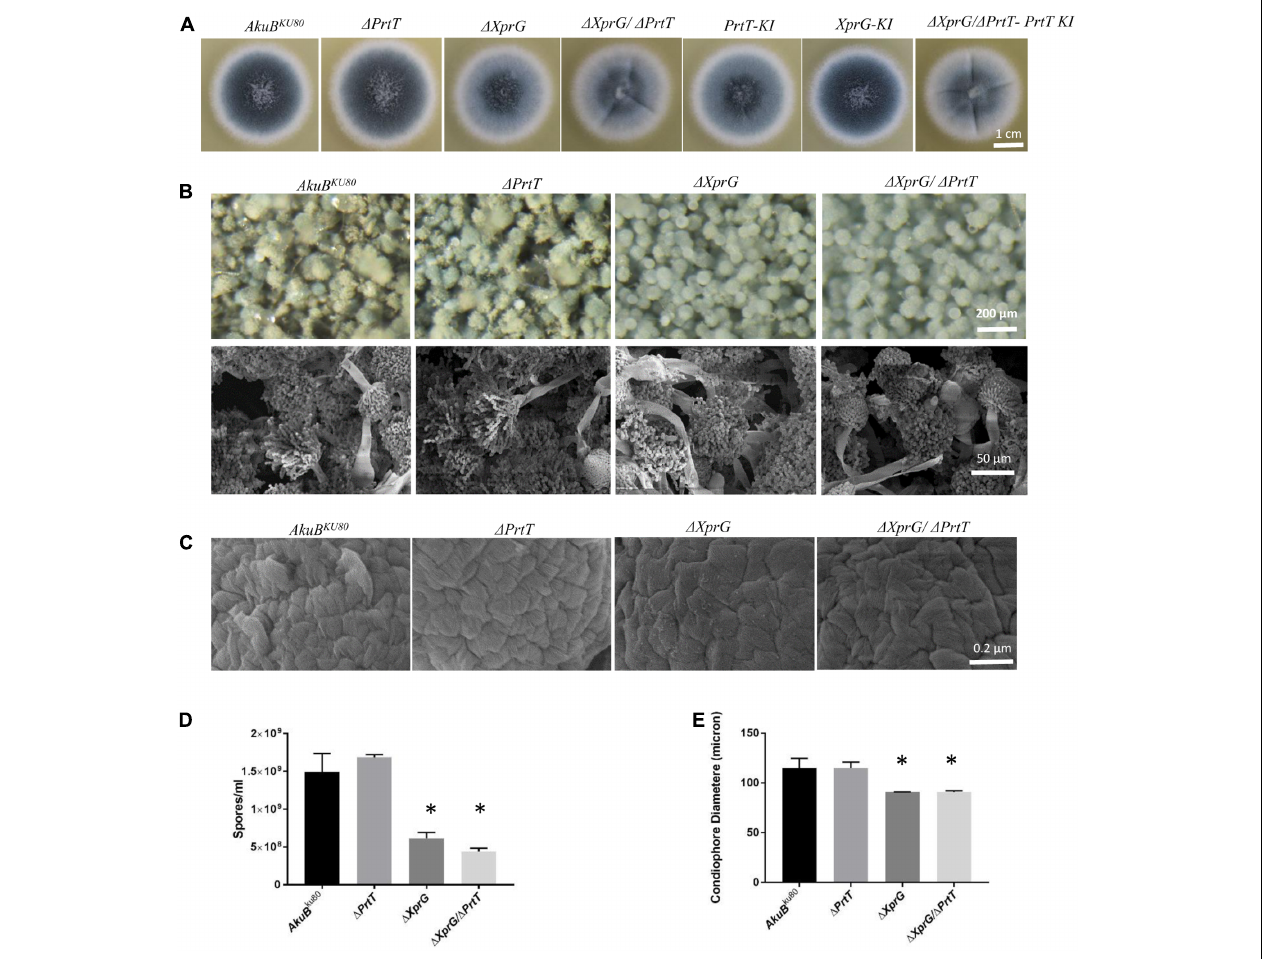
FIGURE 1 | Deletion of xprG and xprG / prtT leads to abnormal conidiogenesis. Phenotypic analysis of the (cid:49) XprG and (cid:49) XprG/ (cid:49) PrtT strains compared to the wild-type AkuB KU80 and (cid:49) PrtT strains shows that they produce (A) lighter colored conidia when growing on YAG agar plates (B) conidiophores with reduced diameter and shorter spore chains (Light microscopy and SEM) (C) conidia with a normal rodlet outer layer (SEM, high magnification), (D) a significantly reduced number of conidia ( ∗ P < 0.005). (E) Quantification of reduction in conidiophore diameter (based on the diameter of 50 conidiophores per strain) ( ∗ P <